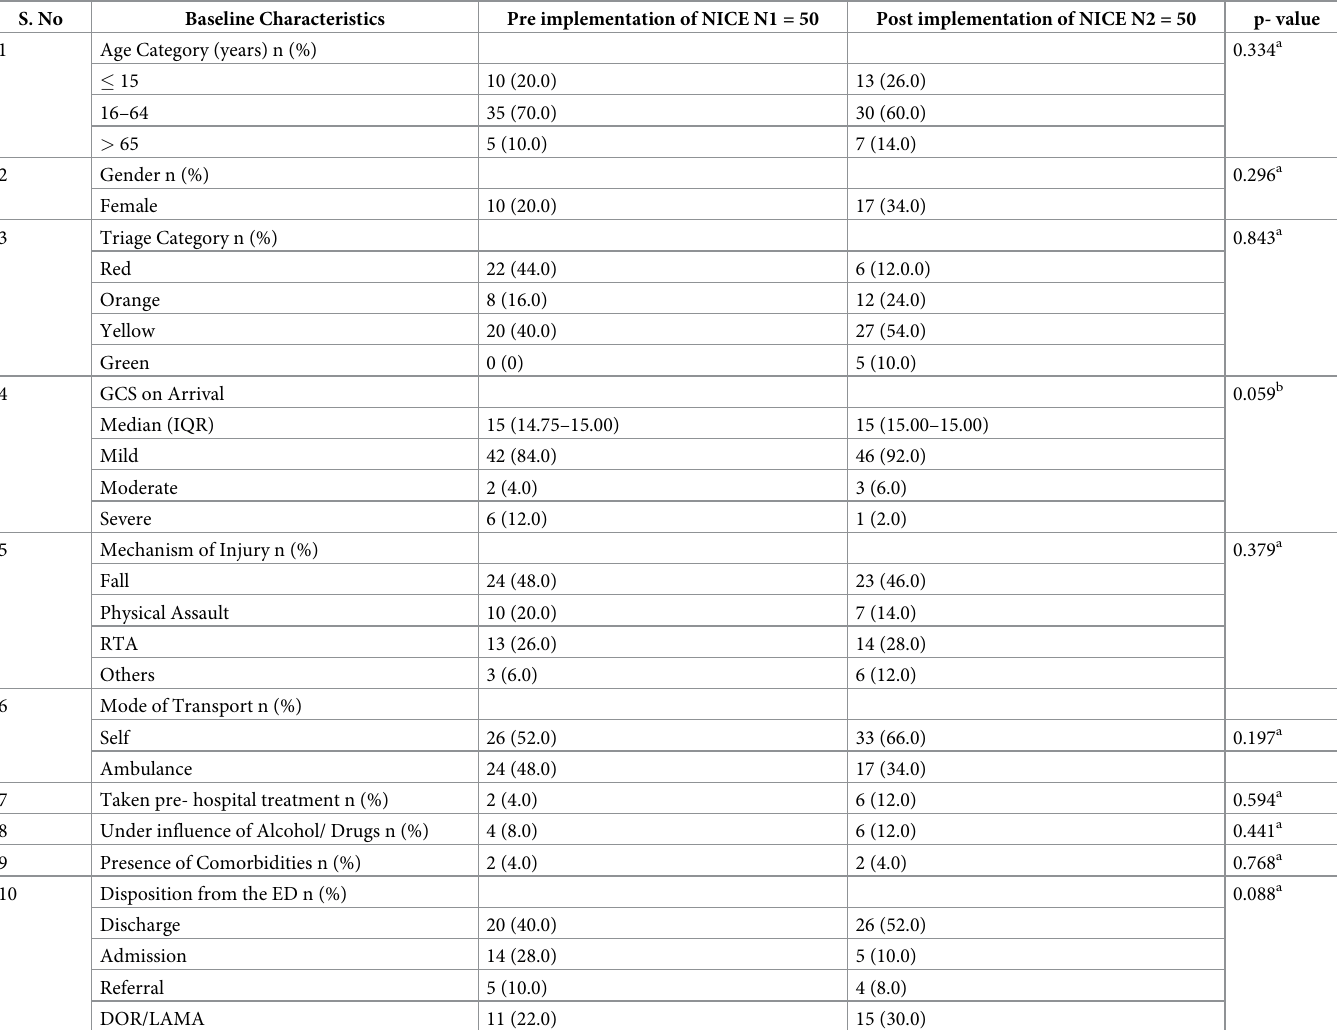
Table 1. Demography, incident details and clinical parameters of the study population, n =